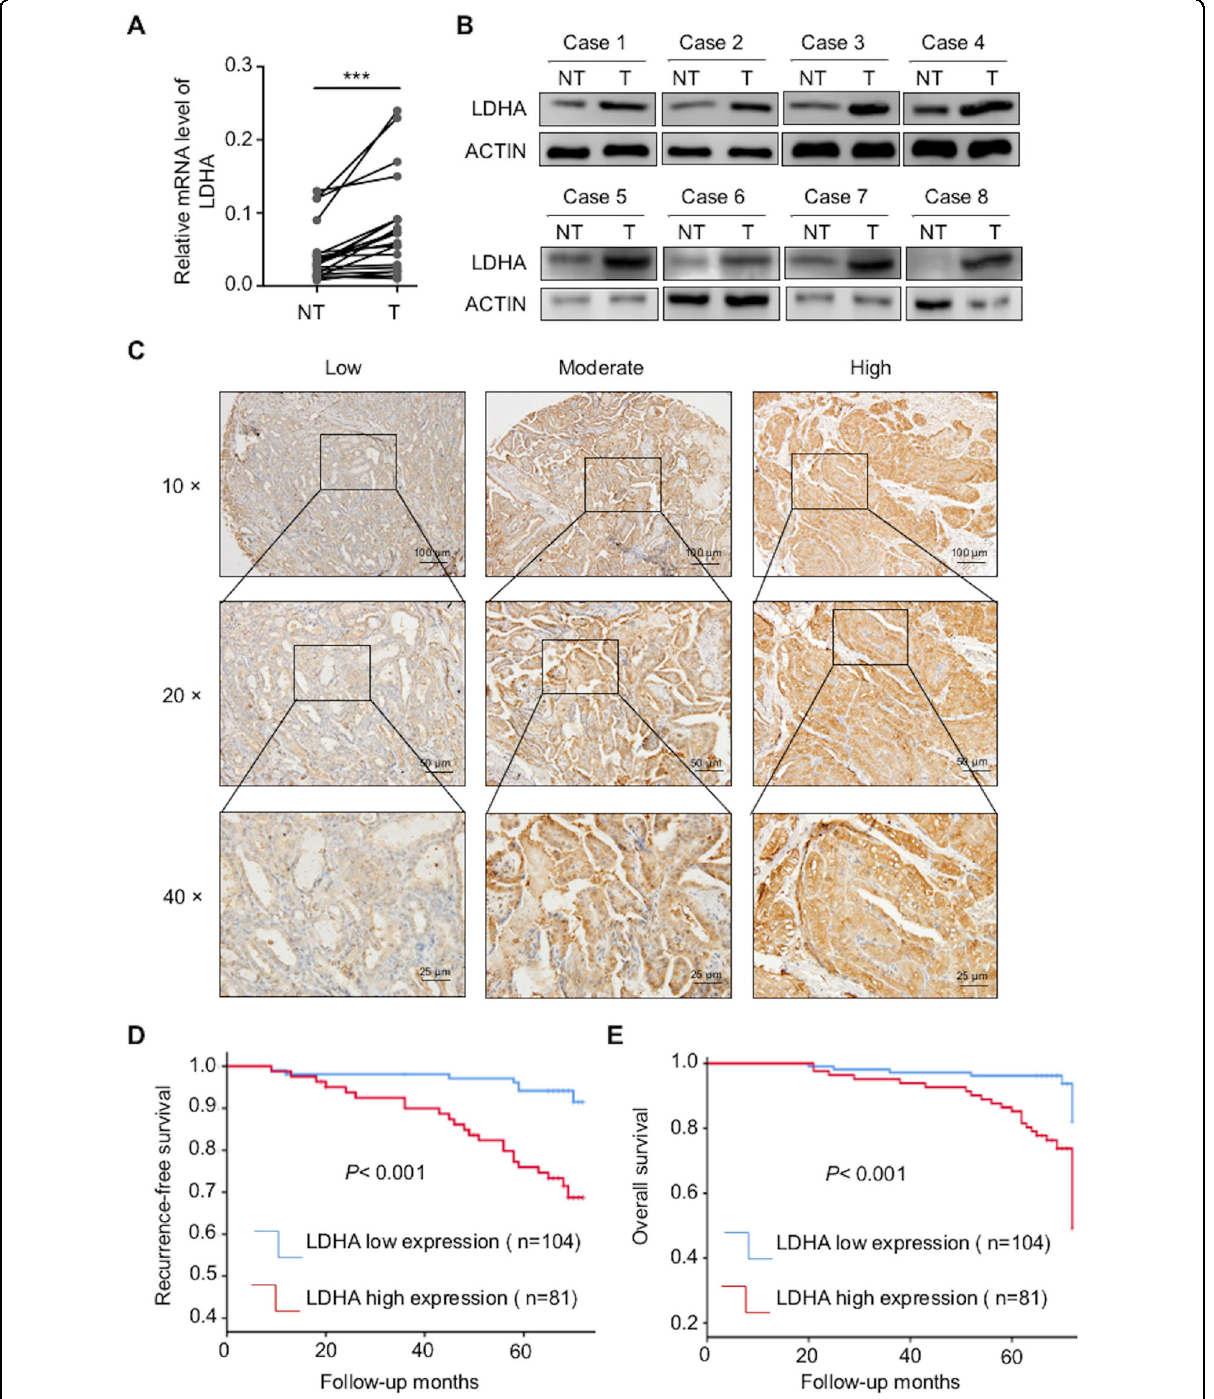
Fig. 2 The expression of LDHA in PTCs and Kaplan – Meier estimates of the probability of OS and RFS in PTC patients. A Expression levels of LDHA mRNA in 20 paired normal tissues and primary tumor tissues. B Expression levels of LDHA in eight paired normal tissues and primary tumor tissues. C LDHA was found to be mainly located in the cytoplasm of PTCs. Representative IHC images of weak staining, moderate staining, and strong staining were shown. D , E Kaplan – Meier survival analysis showed that high LDHA levels were signi fi cantly associated with poor RFS and OS in PTC patients. All * p < 0.05, ** p < 0.01, *** p <